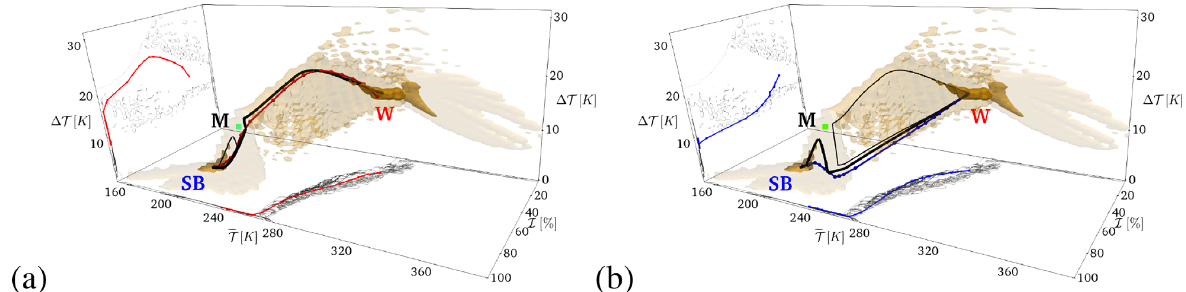
Figure 7. Same as Fig. 6, respectively, using the same 3D projection, lines, and colour coding as in Fig. 4. The subcritical and supercritical paths are depicted as thin and thick solid lines, respectively. The corresponding dashed lines shown in Fig. 6 are not reported here, for simplicity. Here, α = 1 . 0 and (cid:15) = 0 .